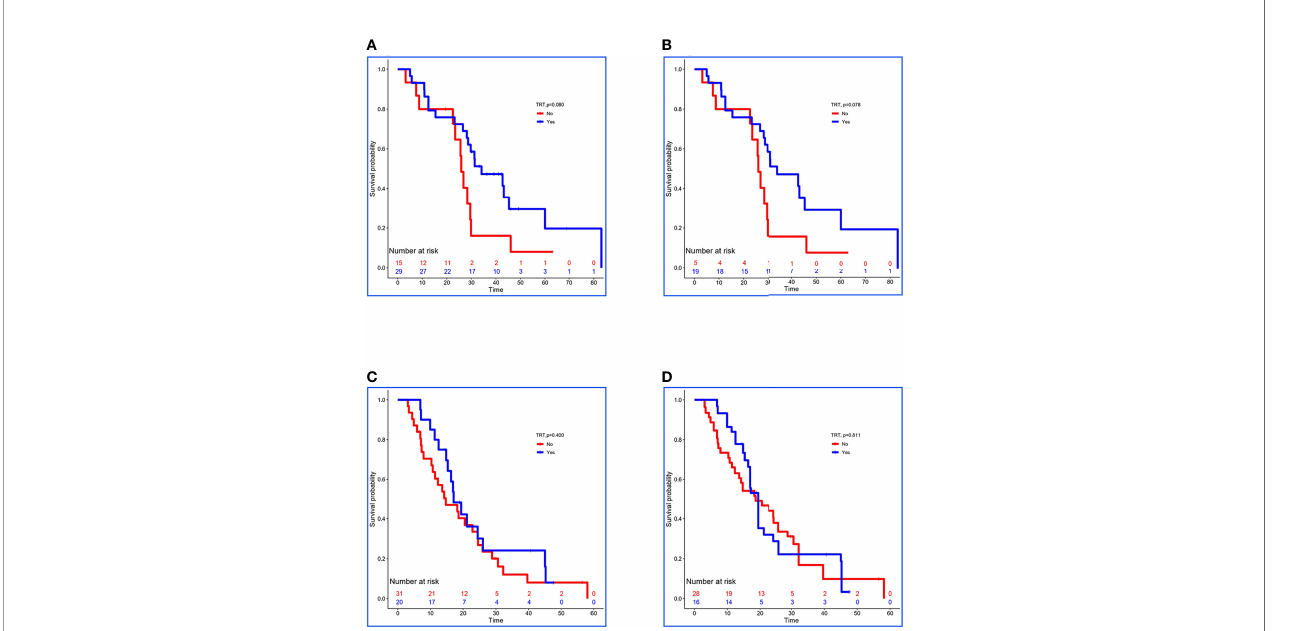
FIGURE 3 | Kaplan – Meier survival analyses for patients between groups. (A, B) Survival curves for low-risk patients between non-TRT and TRT groups when clinical characteristics were unmatched and matched using stabilized IPTW analysis in the validation set. (C, D) Survival curves for high-risk patients between non-TRT and TRT groups when clinical characteristics were unmatched and matched using stabilized IPTW analysis in the validation